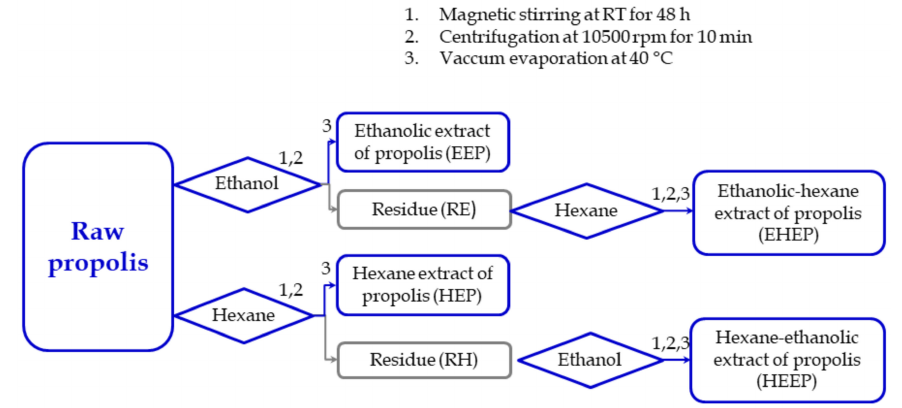
Figure 5. Schematic illustration of procedure for propolis extract preparation; EEP—ethanol extract of propolis, EHEP—ethanol-hexane extracts of propolis, HEP—hexane extract of propolis, HEEP— hexane-ethanol extracts of propolis, RE—residue after extraction with ethanol, RH—residue after extraction with